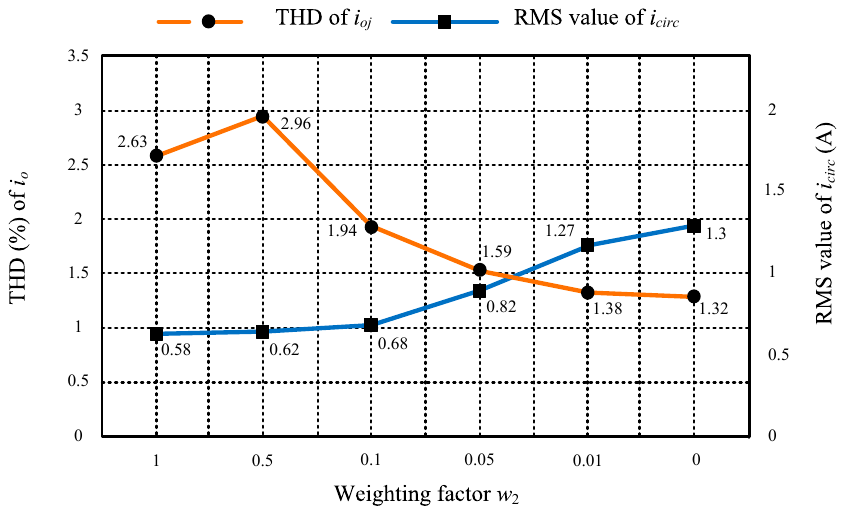
Figure A1. THD values of output currents and RMS values of circulating currents versus varying w 2 ( w 1 = 1).